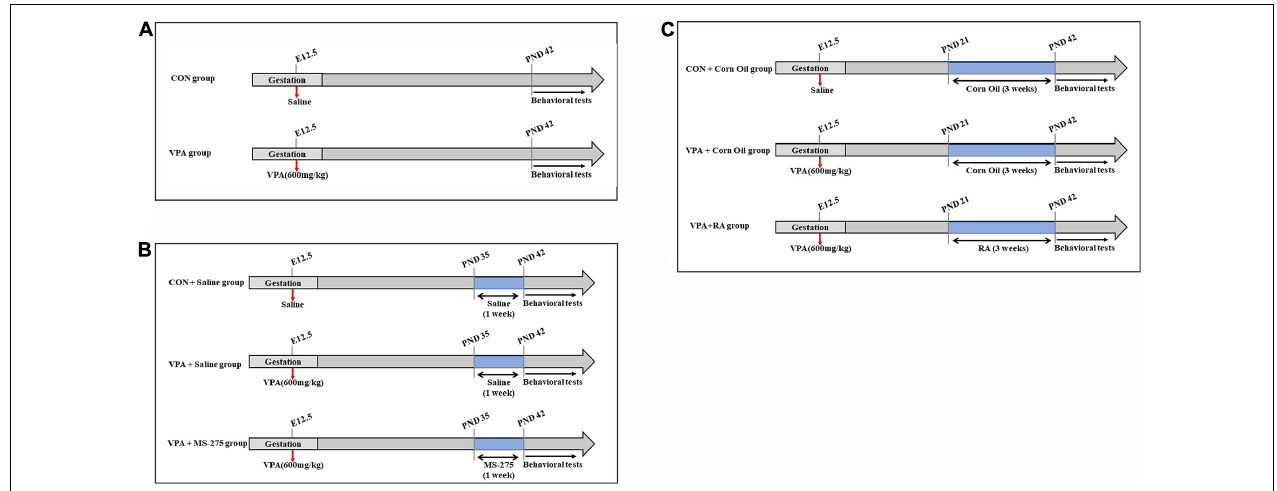
FIGURE 1 | Schematic diagram of experimental design. (A) Schematic diagram of the CON and VPA groups. VPA rats (offspring, n = 28–30) received a single dose of 600 mg/kg VPA by intraperitoneal injection at 12.5 days of gestation, and the CON rats (offspring, n = 28–30) received the same volume of 0.9% saline. (B) Schematic diagram of the CON + Saline, VPA + Saline, and VPA + MS-275 groups. VPA + MS-275 offspring ( n = 28–30) received VPA during pregnancy and an intraperitoneal injection of 3.5 mg/kg MS-275 for a week before each test. Offspring ( n = 28–30 per group) from the CON + Saline group and VPA + Saline group were treated with saline for comparison. (C) Schematic diagram of the CON + Corn Oil, VPA + Corn Oil, and VPA + RA groups. VPA + RA offspring ( n = 28–30) received VPA during pregnancy and oral administration of 6 mg/kg RA once daily for 3 weeks before each test. Offspring ( n = 28–30 per group) from the CON + Corn Oil group and VPA + Corn Oil group were treated with corn oil for comparison. Behavioral tests were conducted beginning at PND 43, and the offspring was sacrificed for brain tissue collection after behavioral tests. VPA, valproic acid; RA, retinoic acid; PND, postnatal day.